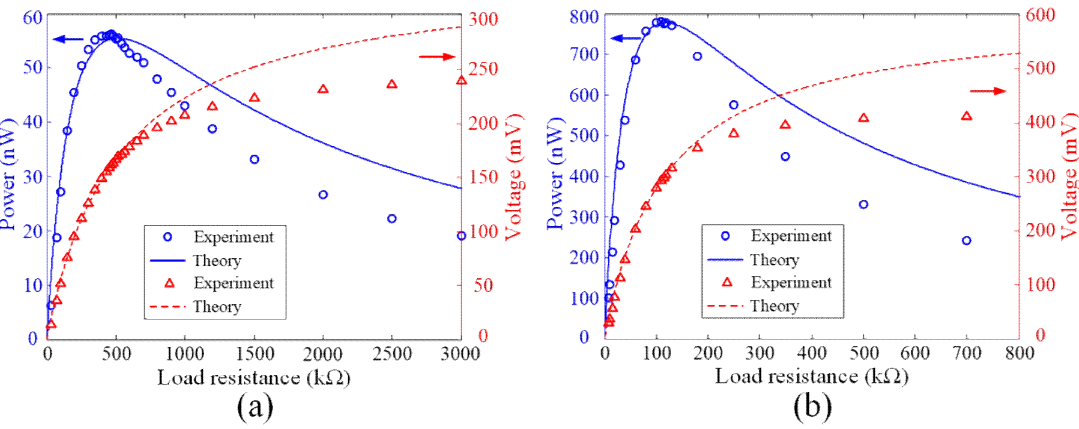
Figure 8. Experimental energy harvesting results at ( a ) the first defect mode (i.e., at 615 Hz) and ( b ) the second defect mode (i.e., 2688 Hz) using EHPC1 (color online).